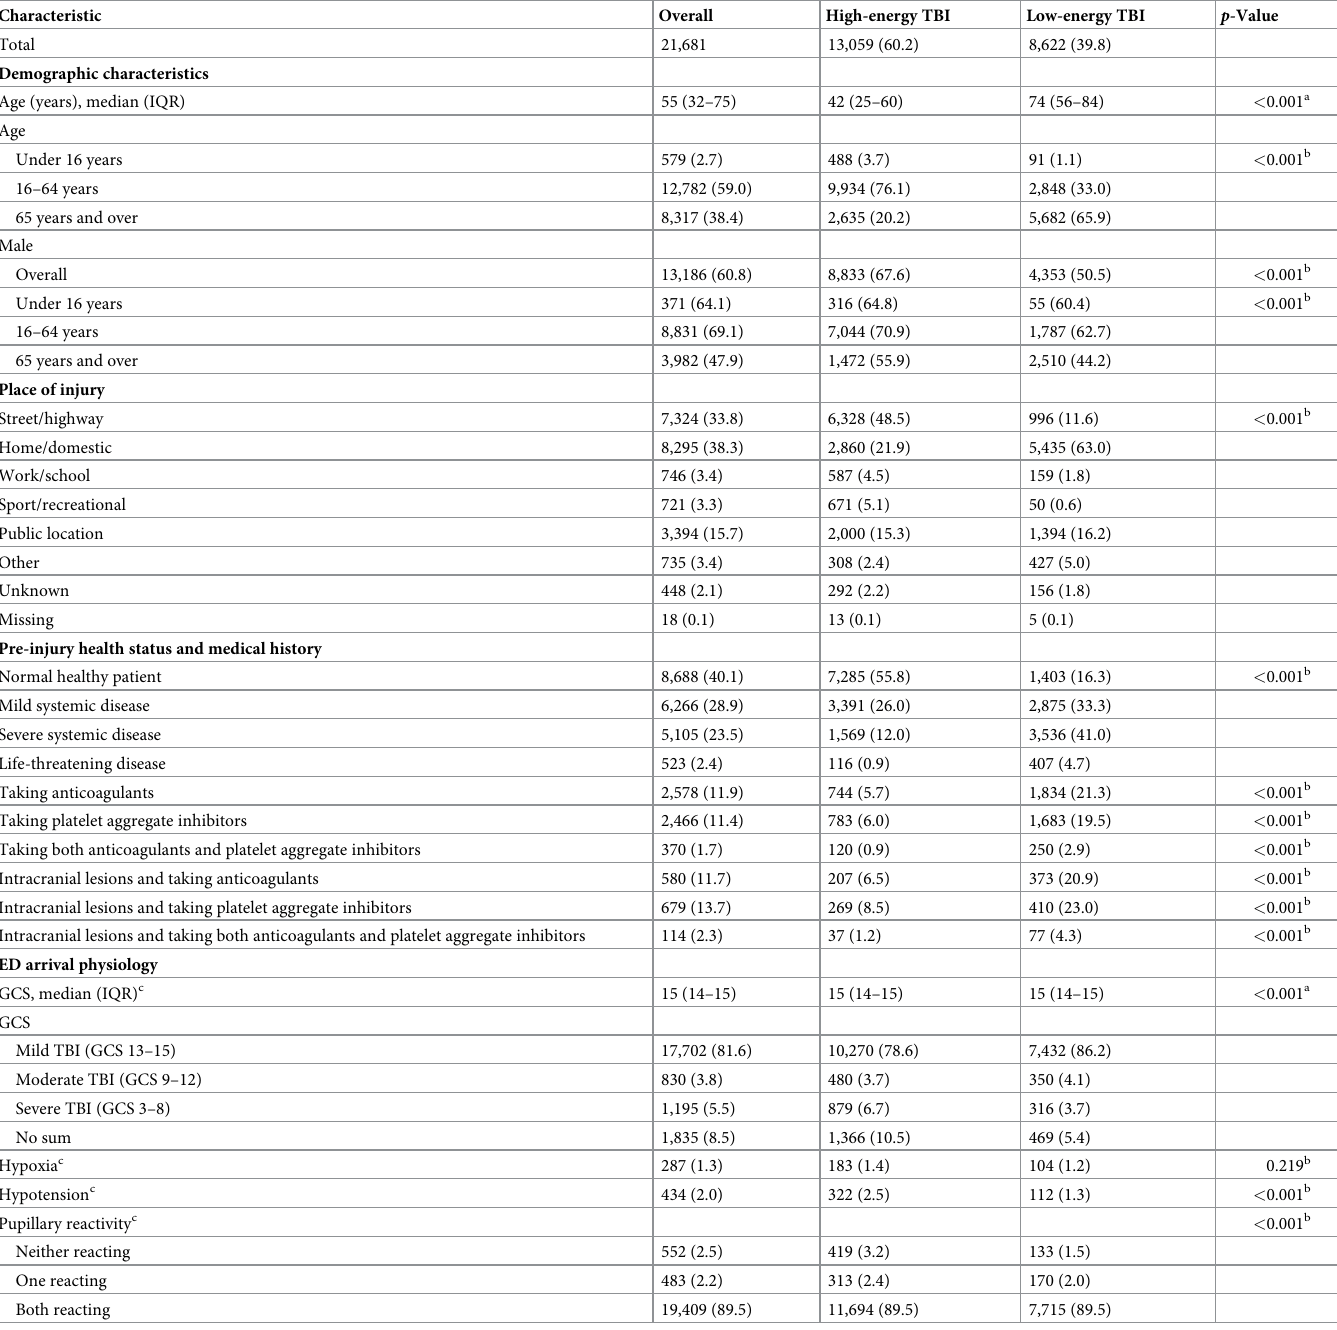
Table 1. Demographics, injury mechanism, comorbidity, and presenting physiology of 21,681 TBI patients enrolled in the CENTER-TBI